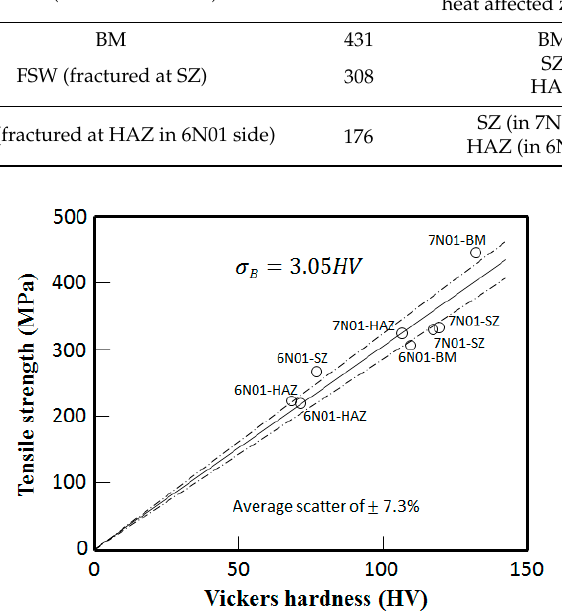
Figure 9. Relationship between the Vickers hardness and tensile strength for various locations in the 6N01 FSW and the 7N01 FSW.